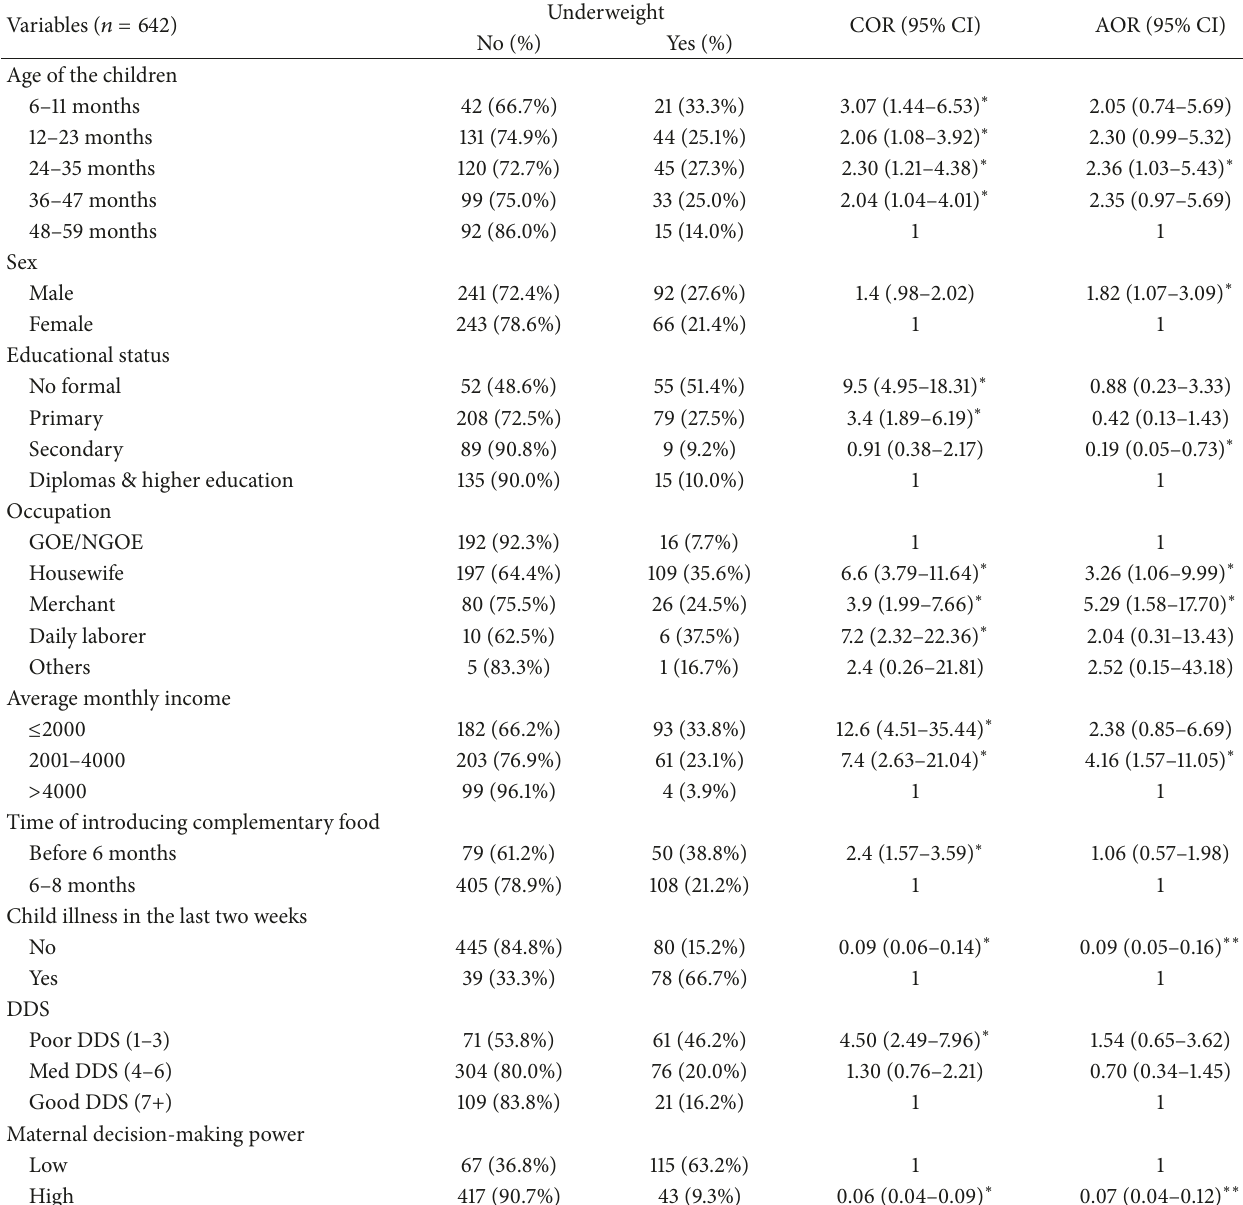
Table 4: Bivariate and multivariate analyses of Sociodemographic characteristics of study participants in Sodo town, southern Ethiopia,